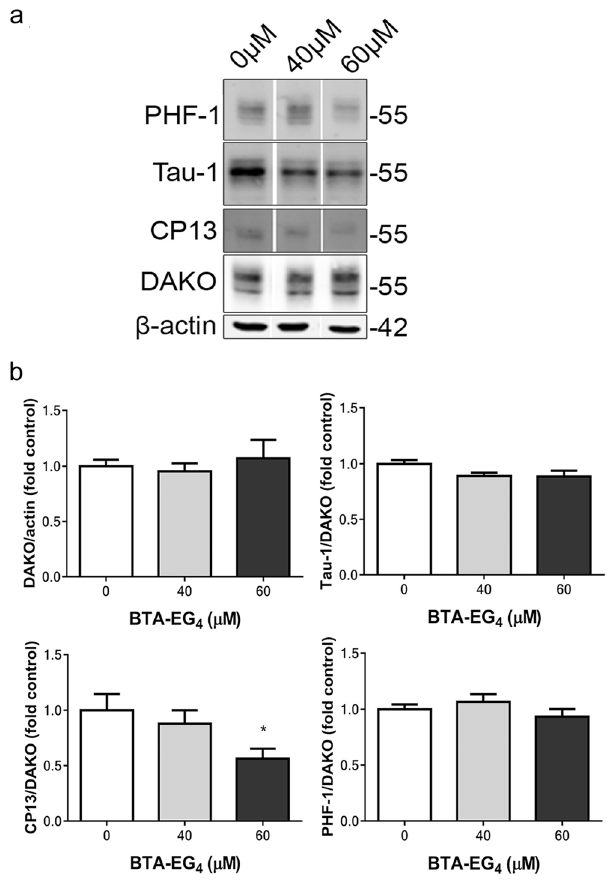
Figure 3. BTA-EG 4 reduces tau phosphorylation in 3xTg-AD brain slice cultures. Representative western blots of lysates from 28 DIV BTA-EG 4 -treated and control (vehicle, DMSO)-treated 3xTg-AD slice cultures. Blots were probed with antibodies against total tau (both non-phosphorylated and phosphorylated; DAKO), PHF-1 (phospho-Ser396/404), Tau-1 (dephospho-Ser199/202/Thr205) and CP13 (phospho-Ser202). Blots were also probed with an antibody against β -actin as a loading control. (C) Bar charts show amounts of total tau relative to β -actin in each sample, and phospho-tau as a proportion of total tau in each sample after treatment with BTA-EG 4 or control. n = 12. Data is mean ± SEM and is shown as fold change from control. * p < 0.05. All data analysed by one-way ANOVA, with post-hoc Dunnett’s multiple comparisons